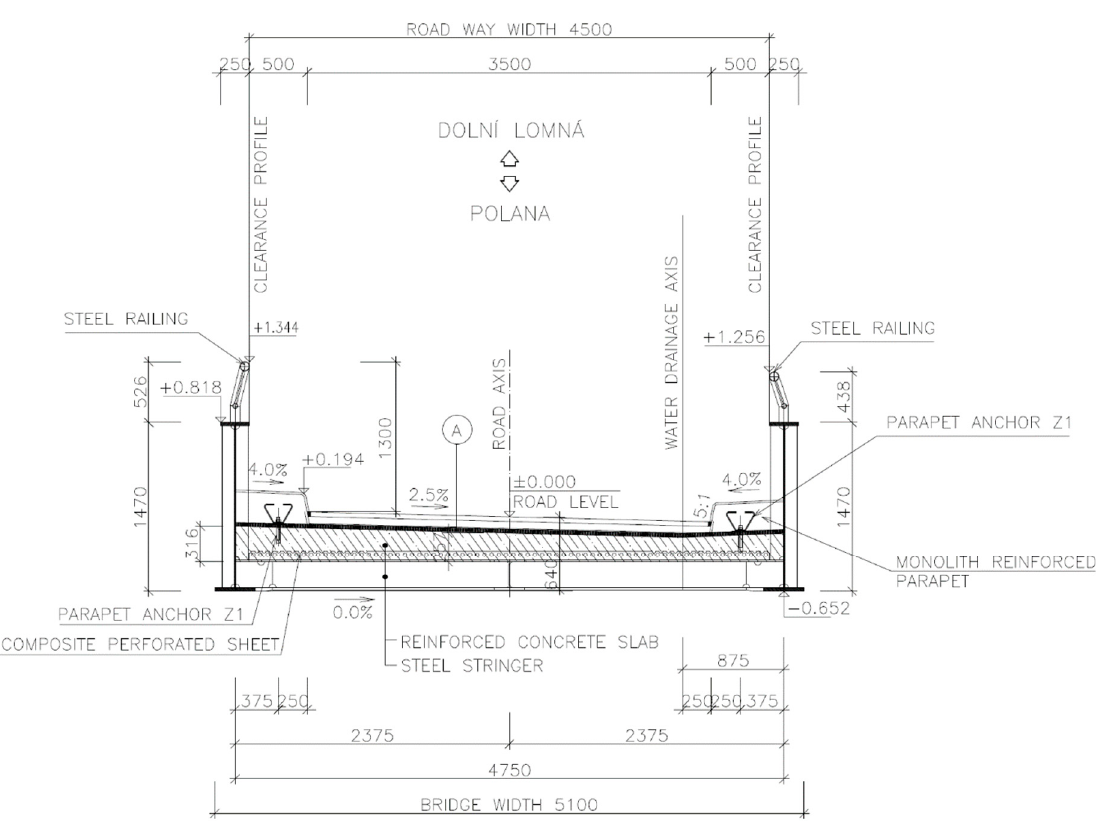
Figure 5. Transverse section of SCB bridge (scale 1:50).